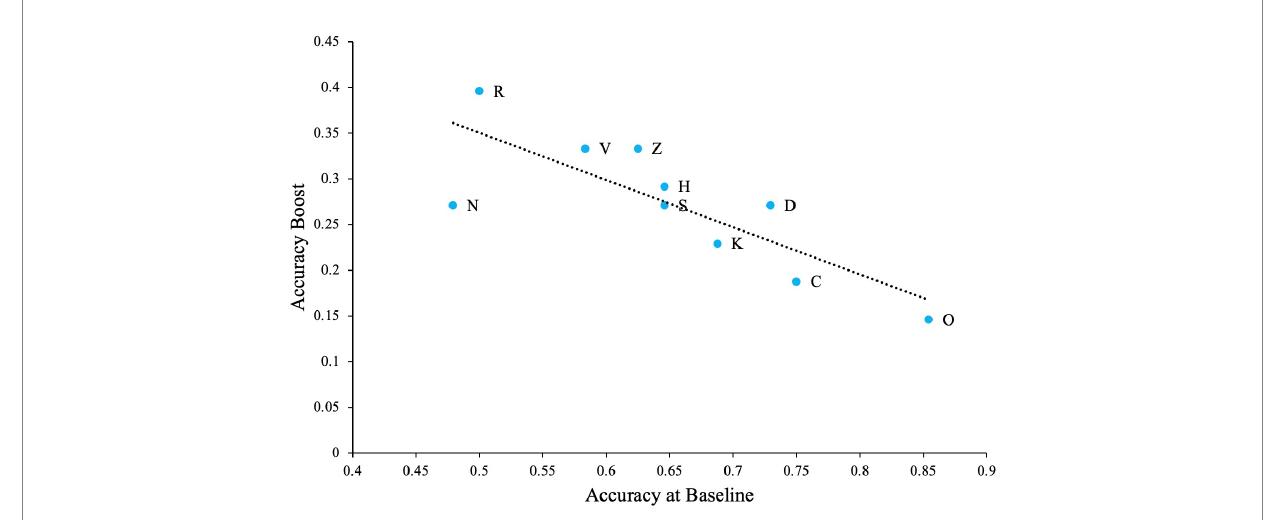
FIGURE 4 The impact of SR when the task contains confusable letters. Dashed line Indicates the regression line (trendline). Plot shows negative association between baseline accuracy and improvement in accuracy above baseline (accuracy boost). The baseline is accuracy of participants at zero external noise